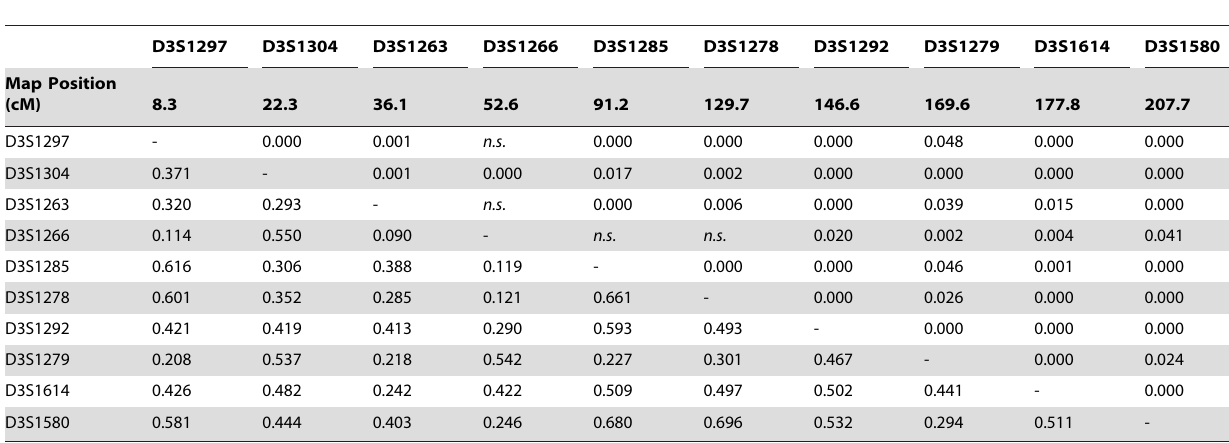
Table 2. Mantel test results with pair of D A distance matrices of different